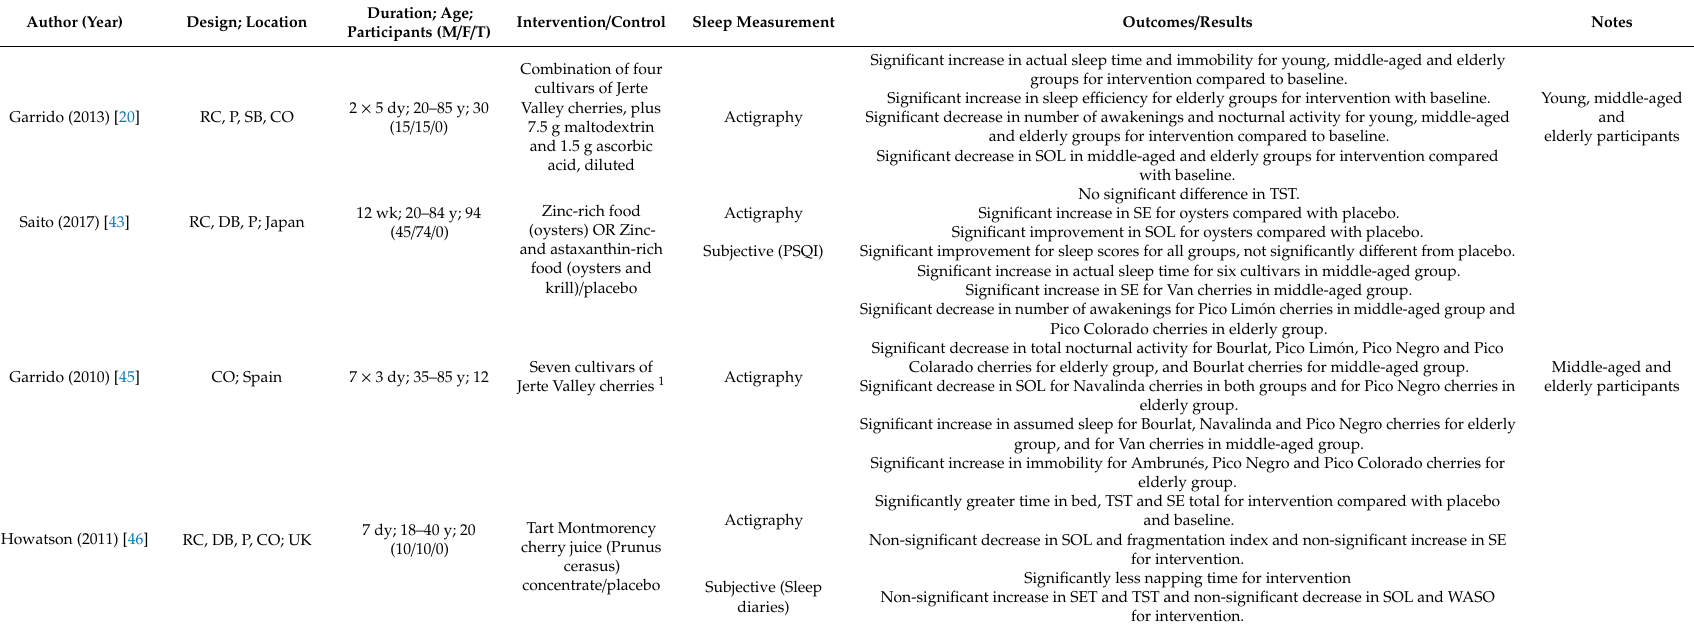
Table 3. Study characteristics and outcomes for investigations between food items and